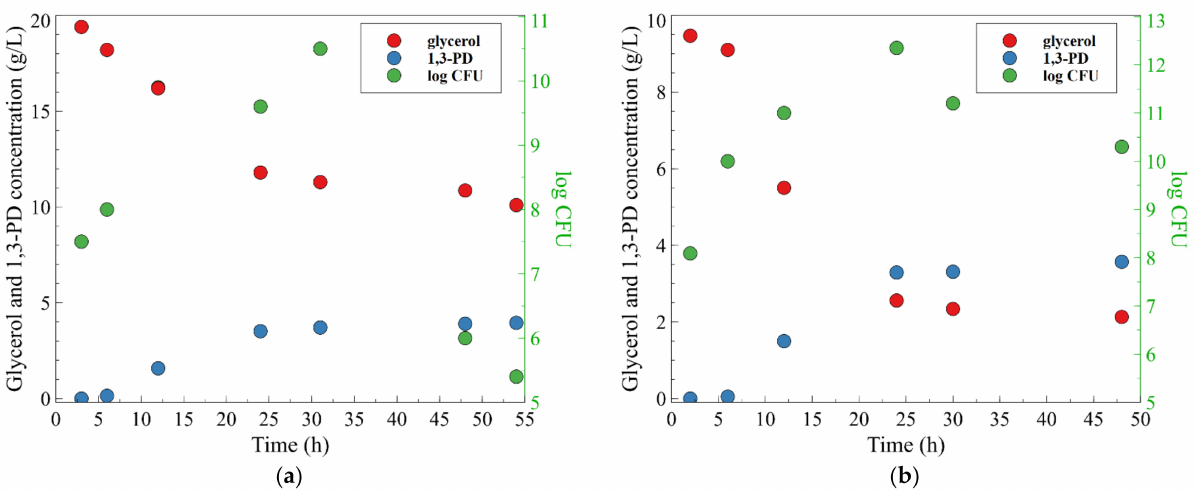
Figure 2. The changes of glycerol and 1,3-propanediol concentrations and number of viable cells of bacteria in the broth during the fermentation process, under conditions of uncontrolled pH. Initial glycerol concentration: ( a ) 20 g/L; ( b ) 10 g/L.